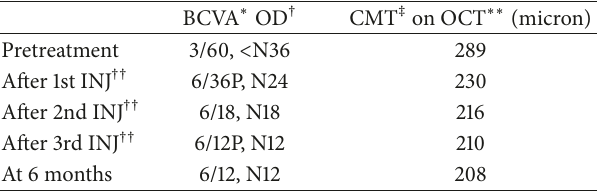
Table 1: Visual acuity and macular thickness.